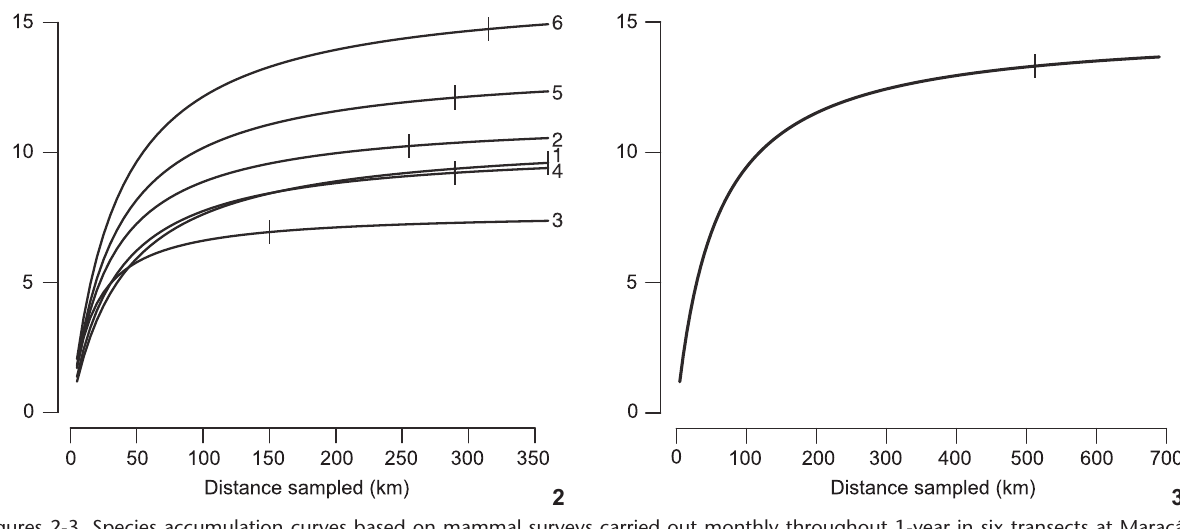
Table I. Estimates of mammal species richness and sampling effort performed in six 5-km long transects at Maracá Ecological Station, Roraima, Brazil. Transect Observed species richness